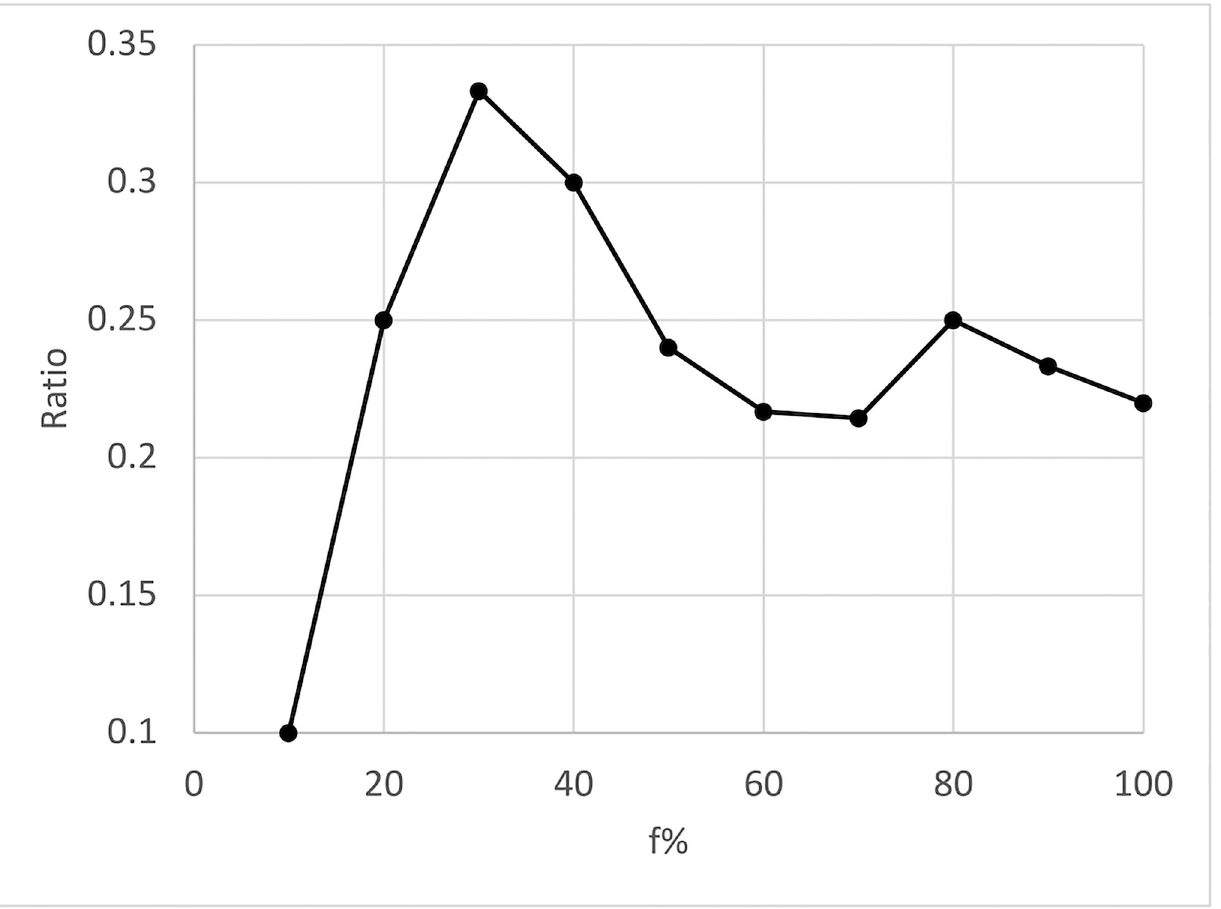
Fig 5. Ratio between the number of diseases with Overlap = 1 and f % . The highest ratio is achieved at f % = 30%.